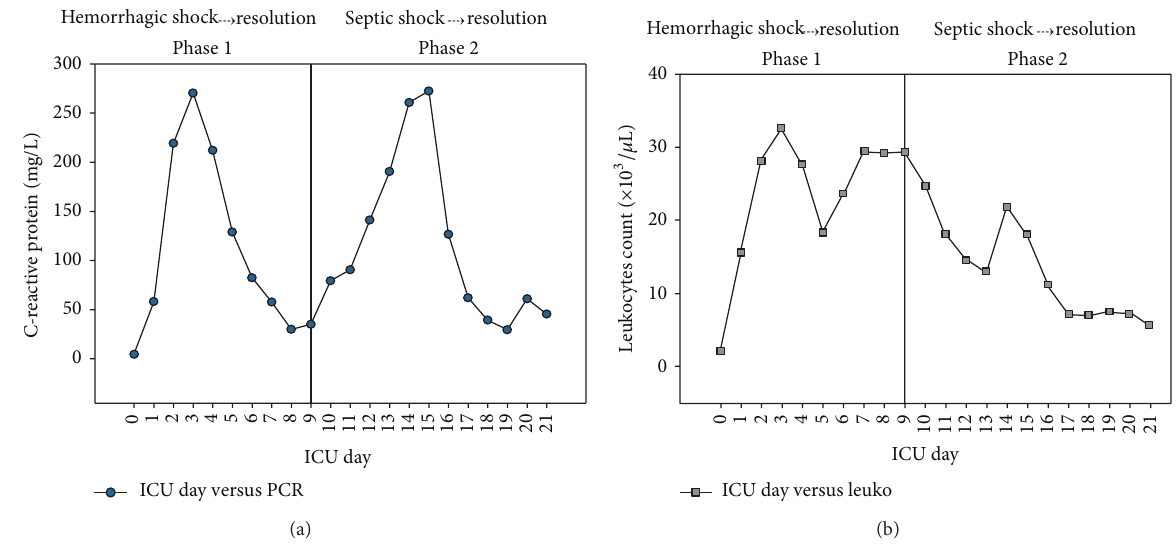
Figure 1: Serum C-reactive protein concentration (a) and leukocytes count (b) in the course of hemorrhagic shock development and resolution (phase 1) and subsequent septic shock development and resolution (phase 2). ICU: intensive care unit.